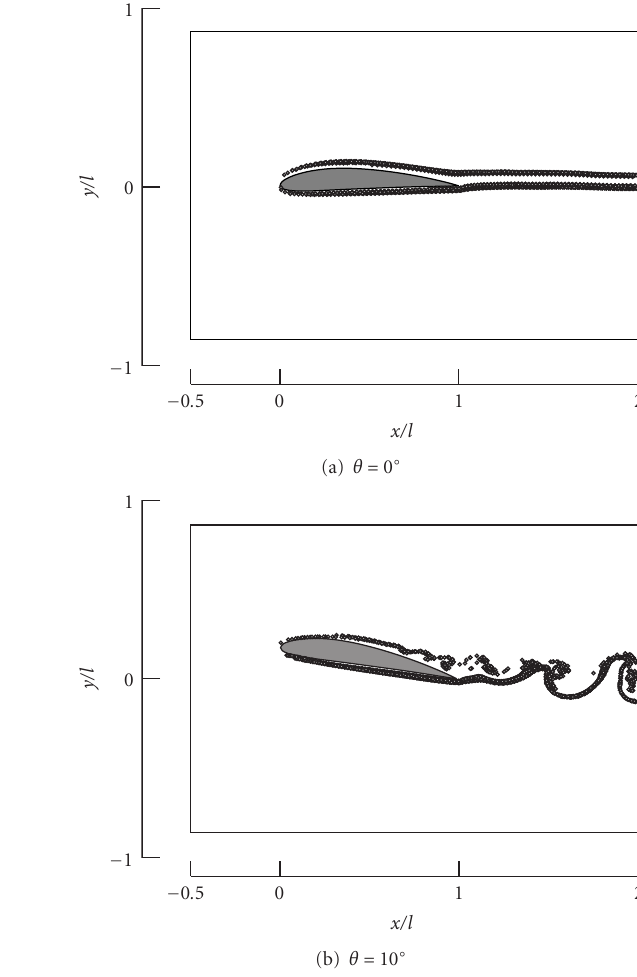
Figure 5: Distribution of vortex